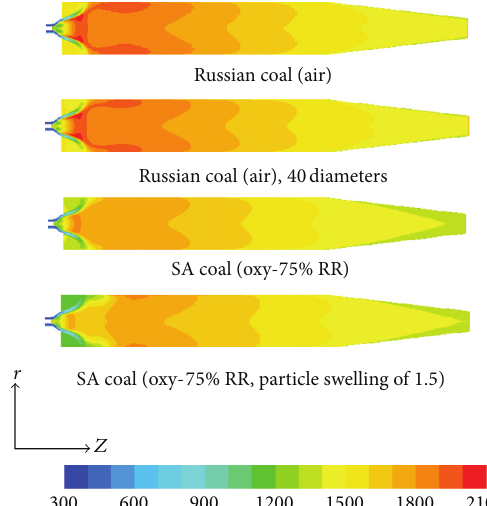
Figure 16: Sensitivities of the temperature contours to particle swelling and diameter intervals during coal